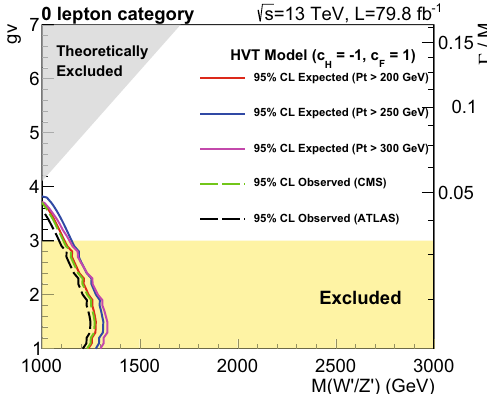
Fig. 13 Expected 95% CL HVT limits as a function of the reso- nance mass and width, for an integrated luminosity of 79 . 8 fb − 1 . The limits for the 0-lepton category are shown for increasing p ⊥ > 200 , 250 , 300 GeV selections. Estimated observed limits by ATLAS and CMS are also shown. The theoretically excluded regions corre- spond to regions of small physical mass and large g V coupling, where the HVT model cannot reproduce the SM input parameters α EW , G F and